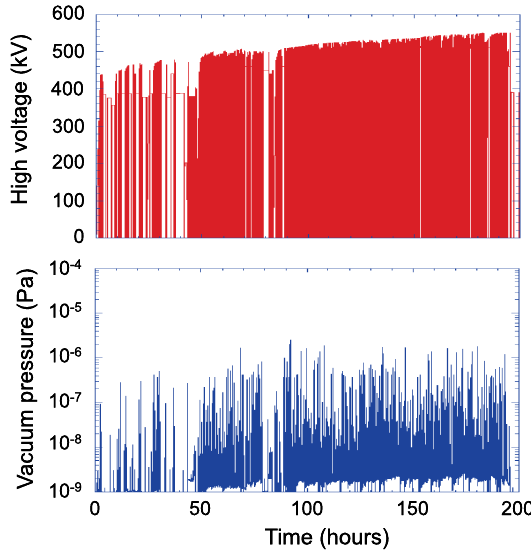
FIG. 10. High voltage (top) and vacuum pressure (bottom) as a function of time during HV conditioning in gun configuration (C), shown in Fig.